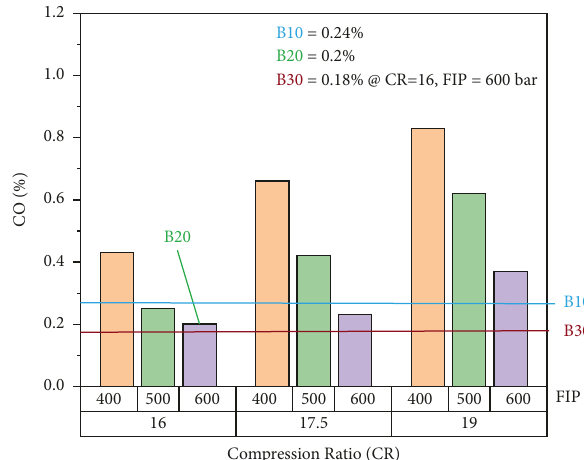
Figure 9: CO emission for HX20 blend at different FIPs and CRs.